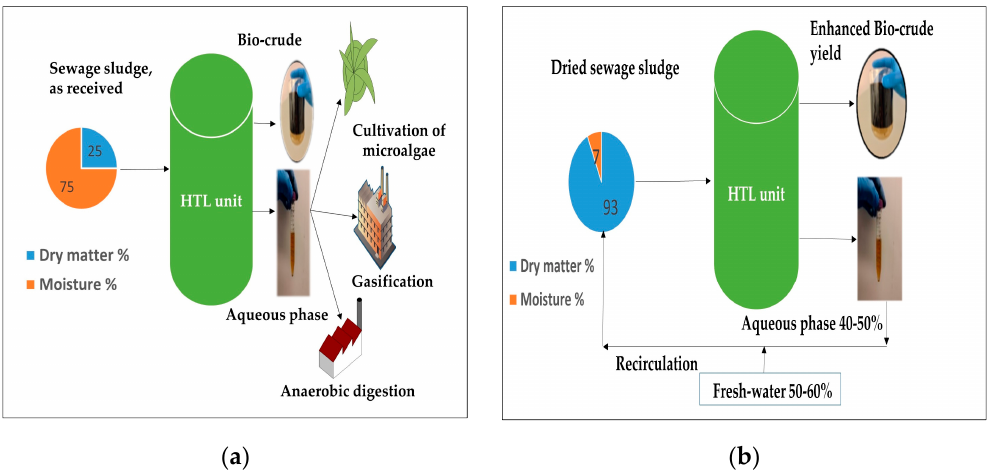
Figure 1. Optimization of the aqueous phase via ( a ) di ff erent processes, ( b ) present study.